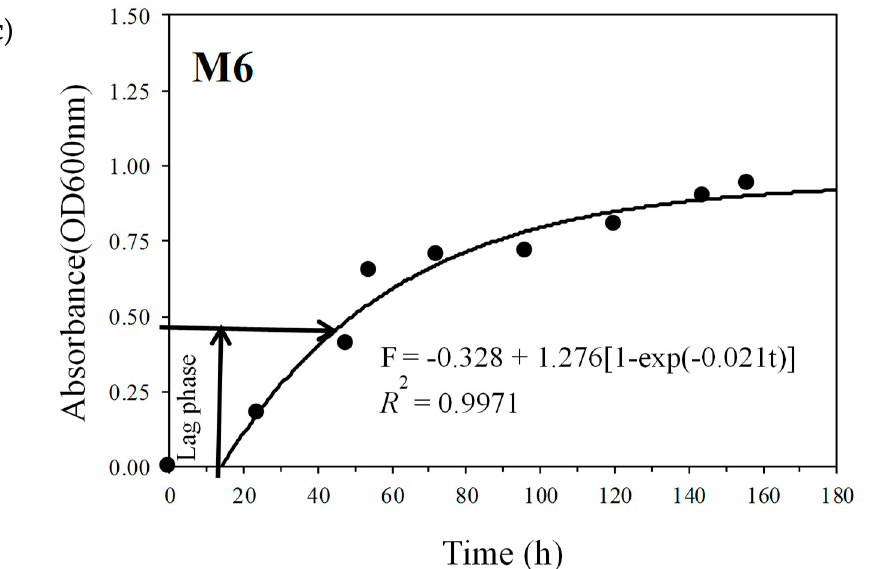
Figure 1. The growth curve of the 1st ( a ), 3rd ( b ), and 6th ( c ) month of breast milk fitted to the regression model in Equation (2). The black points were observed OD600, and the continuous curve line was modelled by Sigmaplot Version 14.